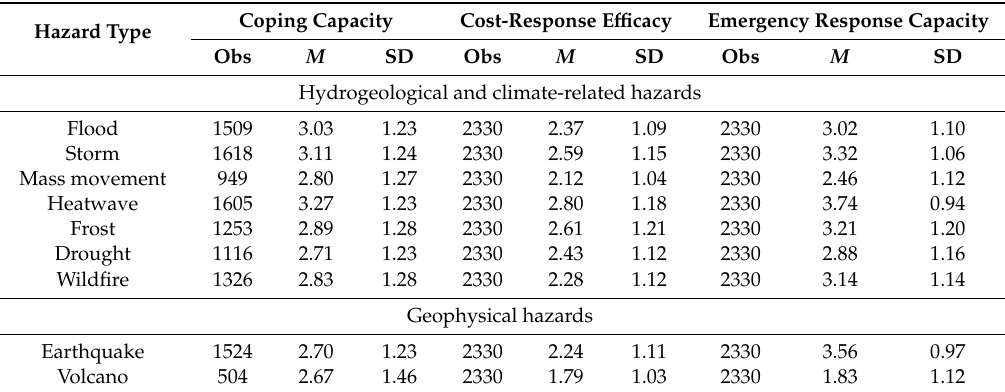
Table 8. Descriptive data for the variables of coping appraisals.